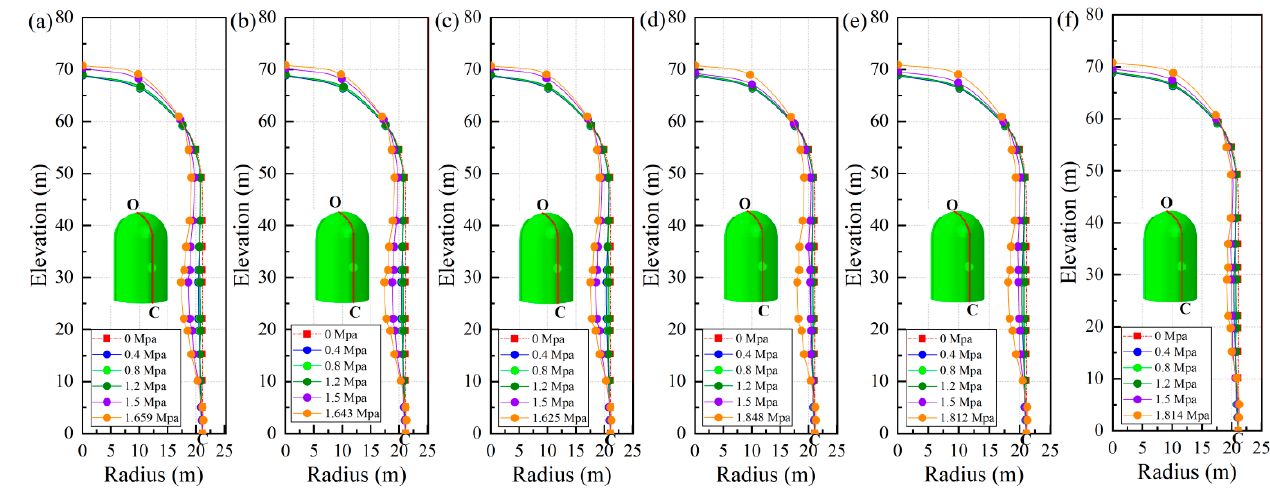
Figure 14. Deformation profile of the fiber-reinforced containment on a large scale of 1:25 (Note: point O is at the top of the dome and point C is at the bottom of the containment): ( a ) basalt fiber; ( b ) carbon fiber; ( c ) PP fiber; ( d ) steel fiber; ( e ) steel-PP fiber; ( f ) steel-PVA fiber. Table 5. The internal pressure between conventional and FRC containment.